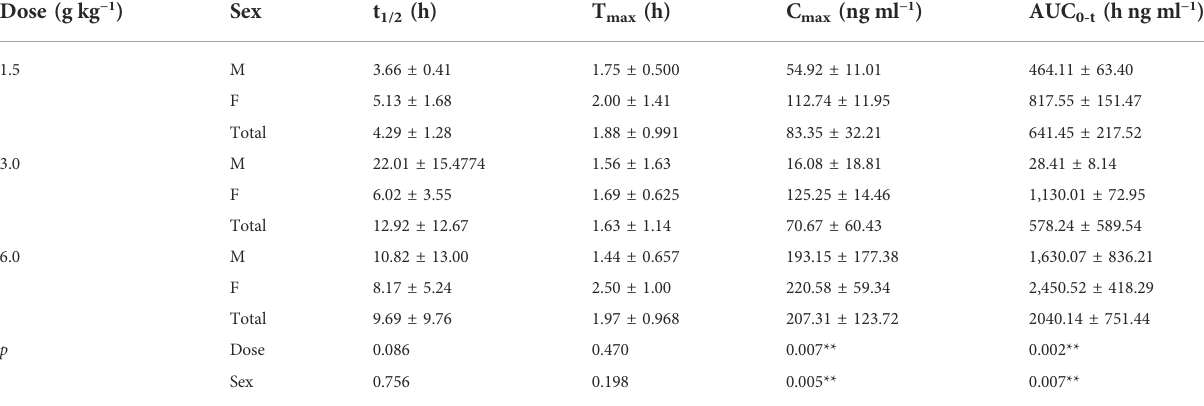
TABLE 3 Pharmacokinetic parameters of agarotetrol after different doses of TYZB in rats (D30). Dose (g kg − 1 ) Sex t 1/2